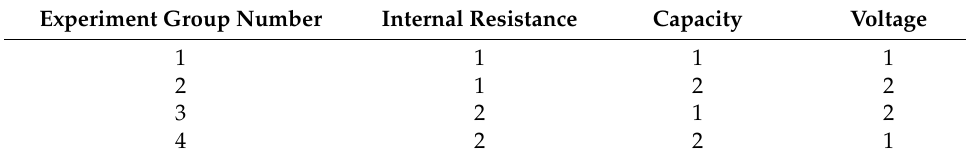
Figure 12. Experiment platform [20]. Table 4. Module equivalent capacity orthogonal experiment table L (2 3 ).